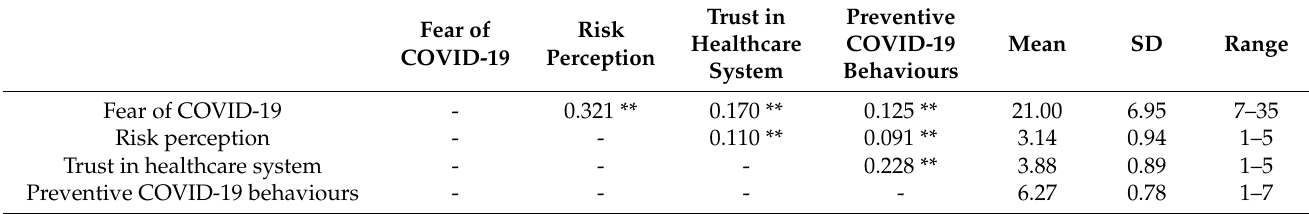
Table 3. Correlation matrix of the study’s